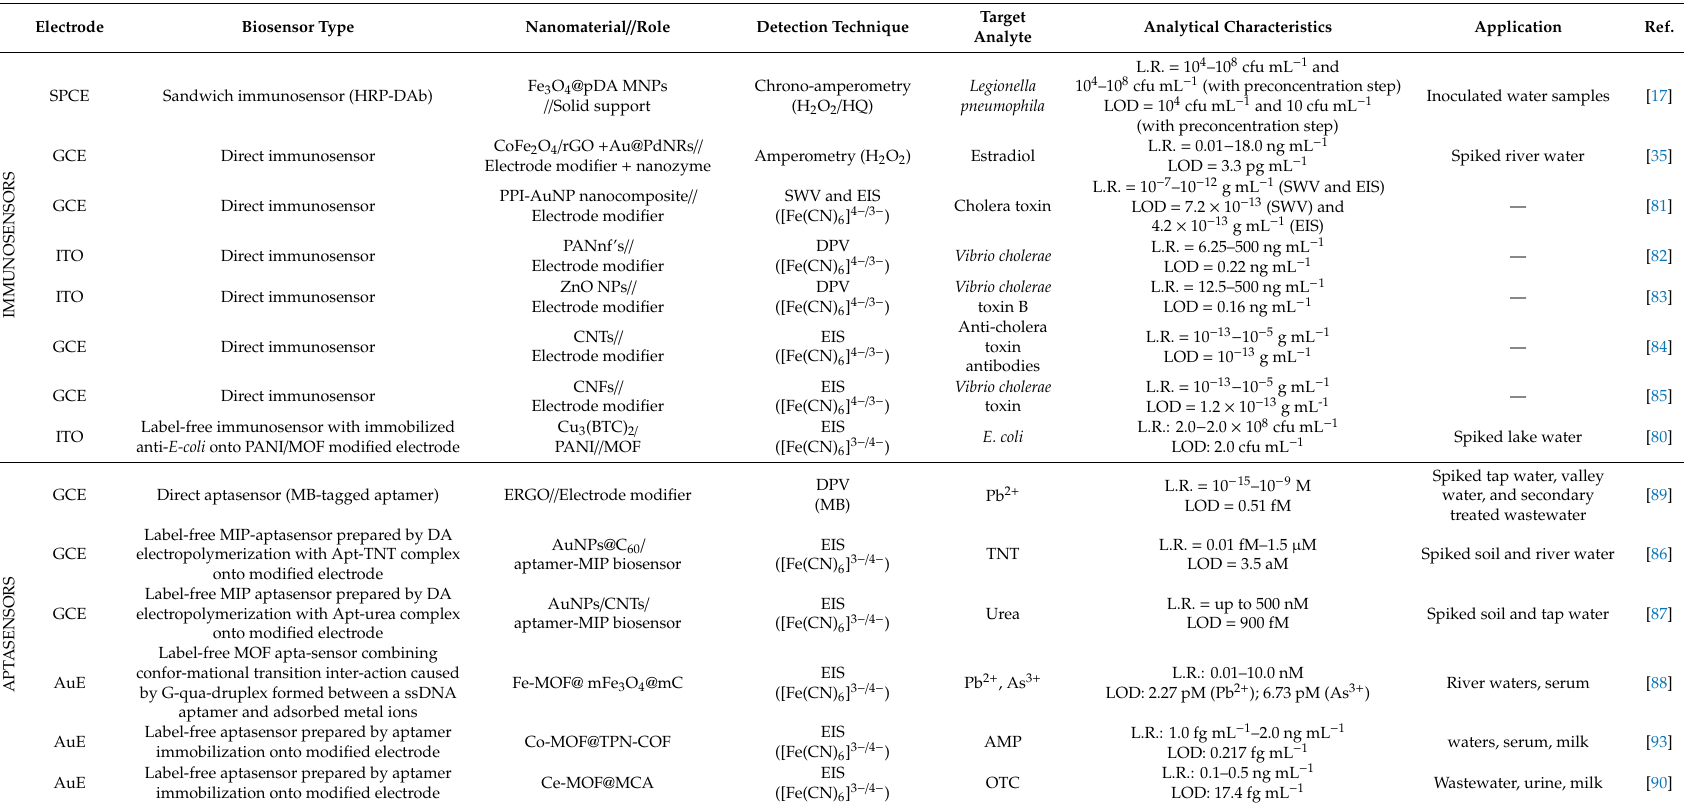
Table 2. Electrochemical biosensors and biosensing method involving nanomaterials for environmental monitoring reported since 2015.